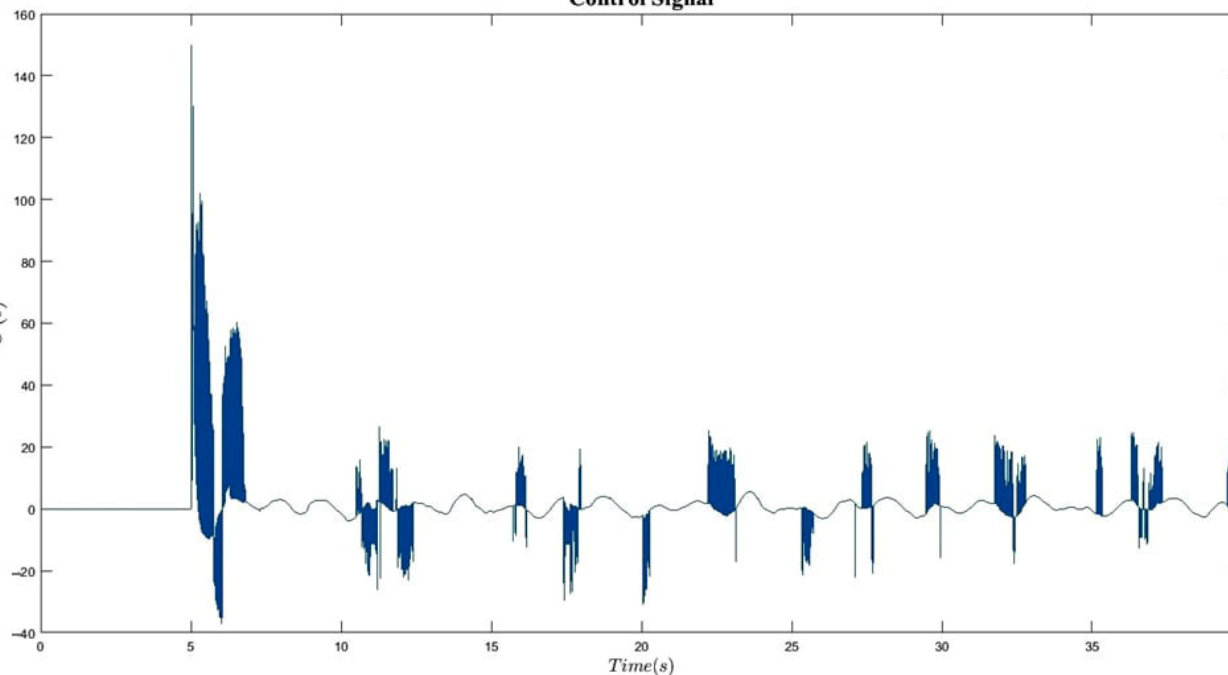
Figure 5. The control signal based on the proposed adaptive sliding mode control.